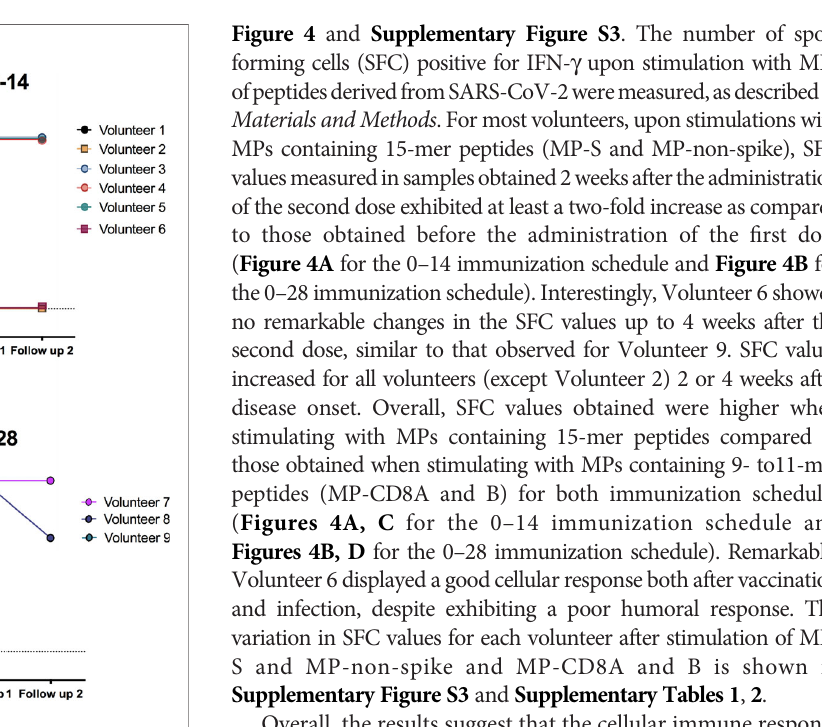
FIGURE 2 | Circulating antibodies response elicited in the nine breakthrough cases measured as IgG speci fi c against the S1-RBD of SARS-CoV-2. Speci fi c IgG antibodies against the S1-RBD of SARS-CoV-2 were evaluated in nine breakthrough cases that received two doses of CoronaVac. The fi gure shows the antibody titer in the serum samples obtained before administration of the fi rst dose (pre-immune), before administration of the second dose (1st dose + 2 weeks or 1st dose + 4 weeks), 2 and 4 weeks after the second dose, and 2 and 4 weeks after the disease onset and a con fi rmed PCR result for SARS-CoV-2 (follow-up 1 and 2, respectively) and a con fi rmed PCR result for SARS-CoV-2. (A) shows the six volunteers enrolled in the 0 – 14 immunization schedule, and (B) shows the three volunteers enrolled in the 0 – 28 immunization